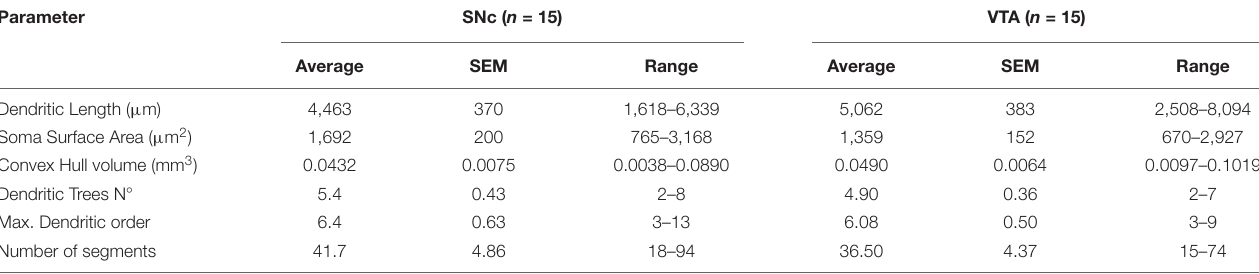
TABLE 1 | Cell body and dendritic arbor size and complexity measures in ventral tegmental area (VTA) and substantia nigra pars compacta (SNc) reconstructed